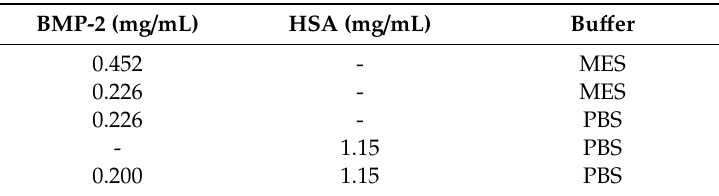
Table 1. Solutions used in AF4 / MALS experiments (cf.